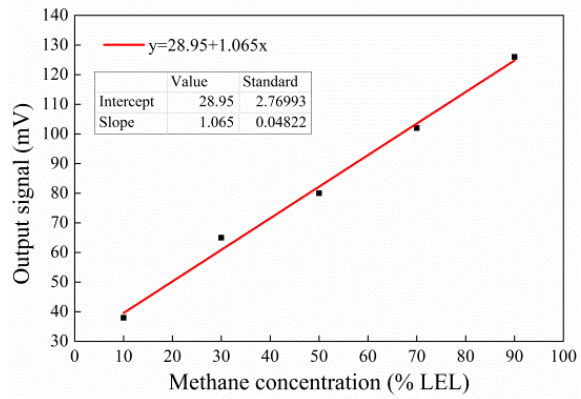
Figure 11. Variation in output signal of the sensor with variable methane concentrations.